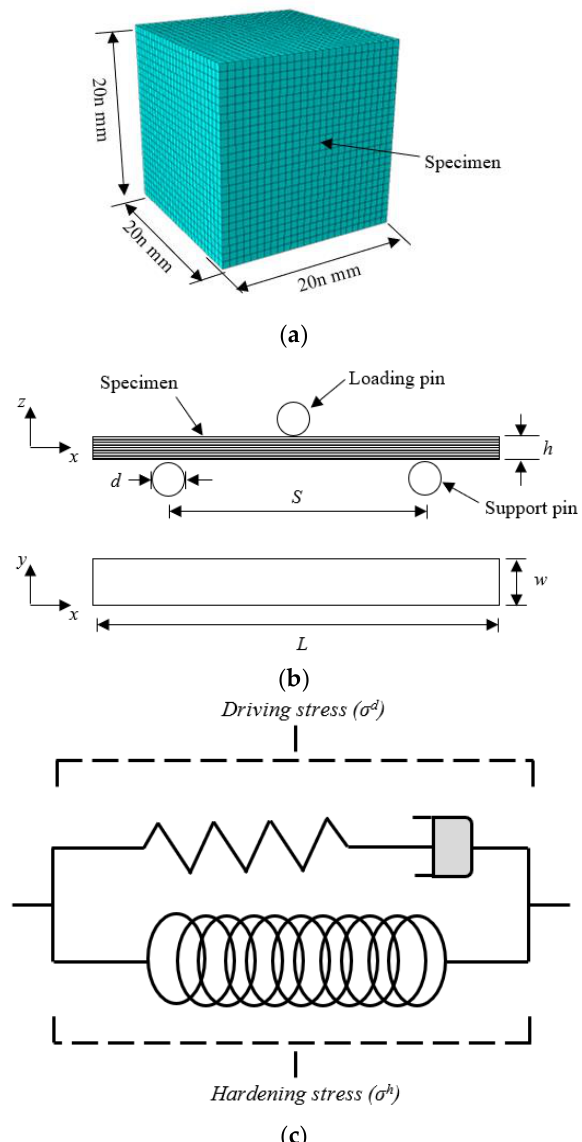
Figure 2. ( a ) Schematic of the cube test sample with an edge length of 20n mm. ( b ) Schematic of the flexural test sample with edge lengths of 200n × 40n × 8n mm 3 . ( c ) The viscoelastic model.